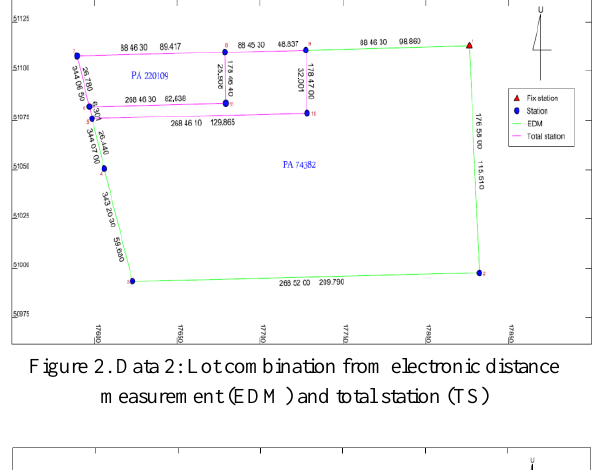
Figure 2. Data 2: Lot combination from electronic distance measurement (EDM) and total station (TS)